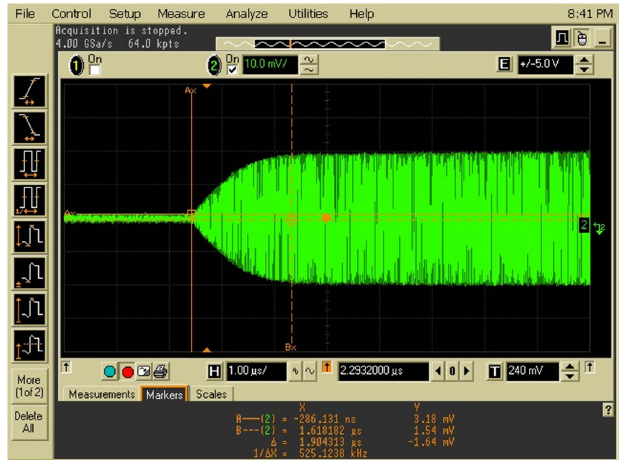
FIG. 19. A zoomed view of the cavity pulse at the rising edge with a settling time of 1 : 9 (cid:2) s